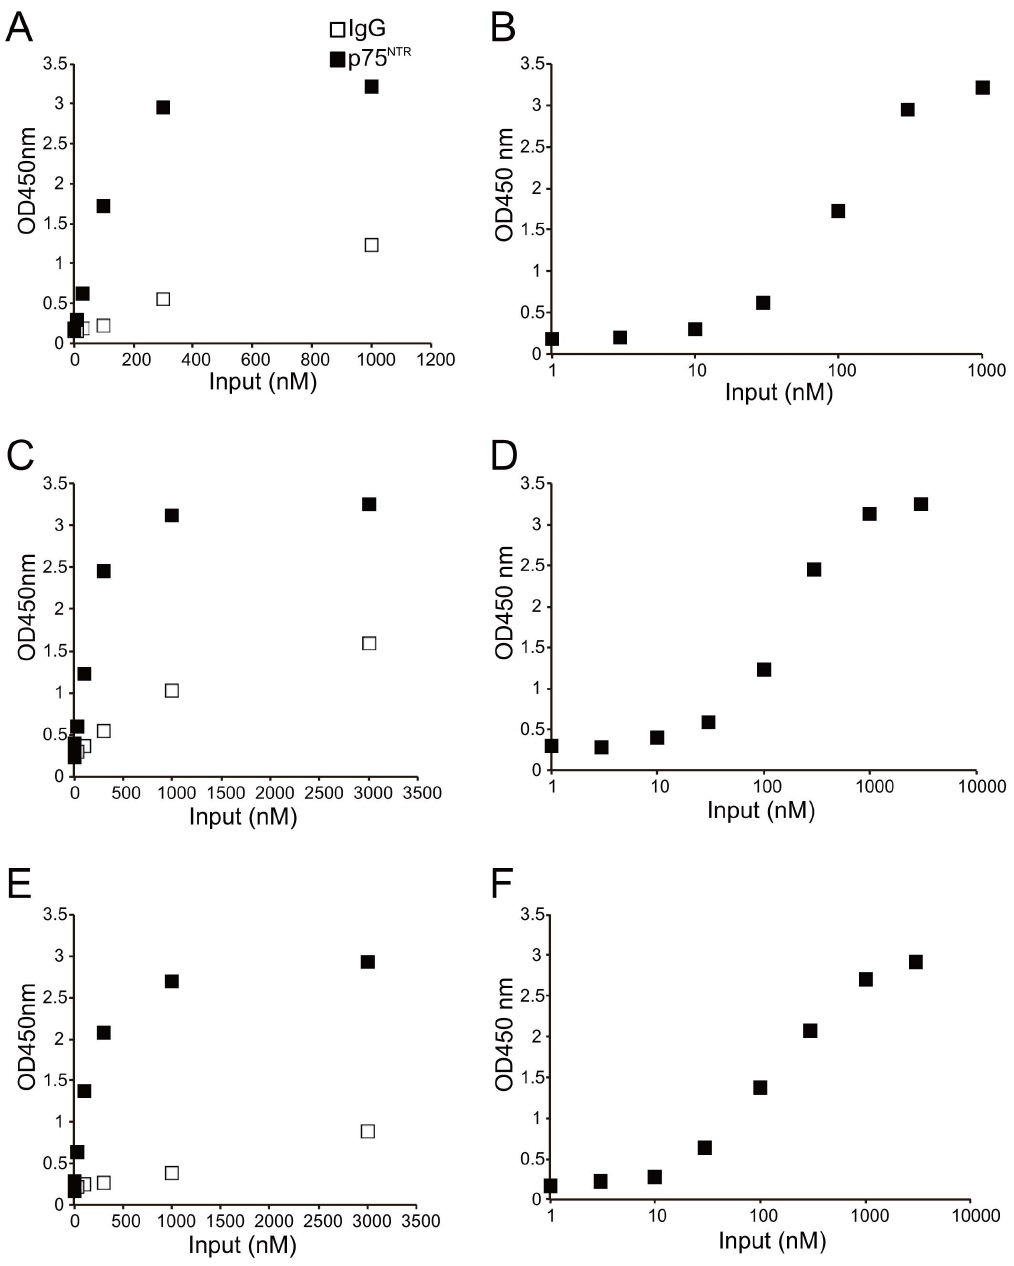
Figure 2. Binding affinity of APP fragments to p75 NTR . (A, C, E) ELISA for the p75 NTR -APP fragments interaction. sAPP a (A), sAPP b (C), or C- sAPP a (E) was plated. After washing with PBS, p75 NTR ECD-Fc or IgG-Fc as a control was added to the plate at the indicated concentrations. The mean OD value after adding p75 NTR ECD-Fc to ELISA microwells coated with recombinant each APP peptides was higher than that of the controls. n=3. (B, D, F) The sigmoid dose-response curve revealed the EC 50 for each APP fragment-p75 NTR interaction. The EC 50 of sAPP a (B), sAPP b (D), and C-sAPP a (F) to p75 NTR were 90, 120, 150 nM, respectively.